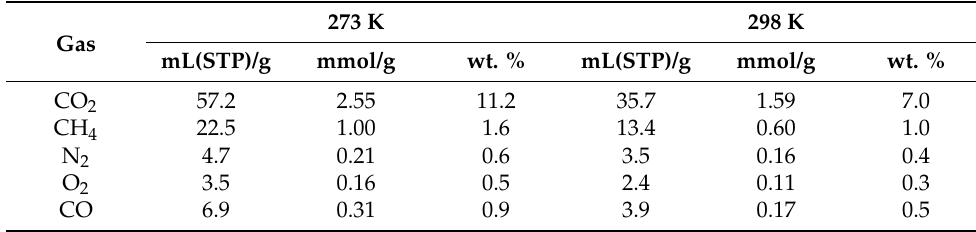
Figure 7. CO 2 , N 2 , O 2 , CO and CH 4 gas adsorption isotherms for the compound 1 : ( a ) at 273 K; ( b ) at 298 K.